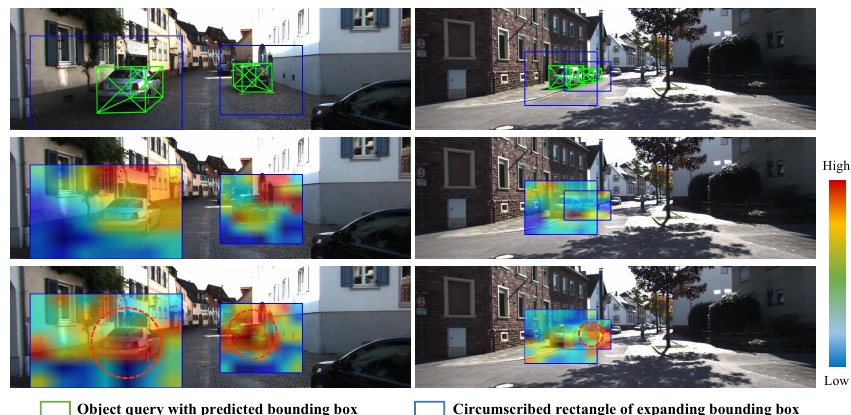
Figure 3. Visualizations of attention map. First Row: input images and the predictions of object queries projected on the images (painted in green), and the circumscribed rectangle of expanding predictions projected on the images are painted in blue. Second Row: Intra-modality self-attention maps within the expanding RoI area of the image branch with high attention weights on the part of the vehicles and background. Third Row: Inter-modality cross-attention maps of image branch, higher attention weights are on the vehicles. Our fusion strategy can dynamically choose relevant image features as supplementary information with the help of the Intra-modality and Inter-modality attention modules. The two images are picked from the KITTI